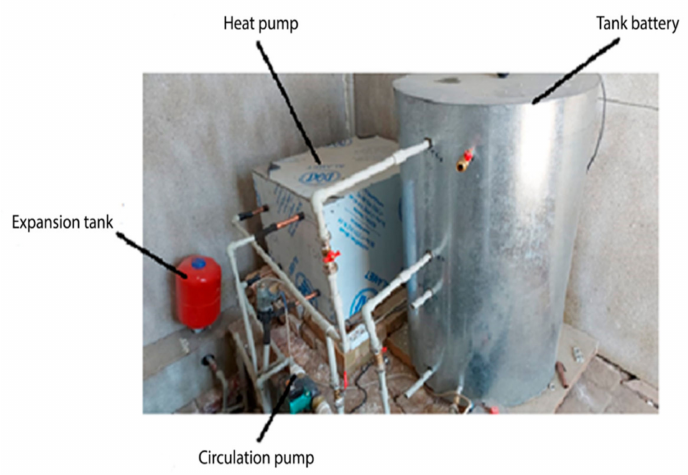
Figure 4. Thermal